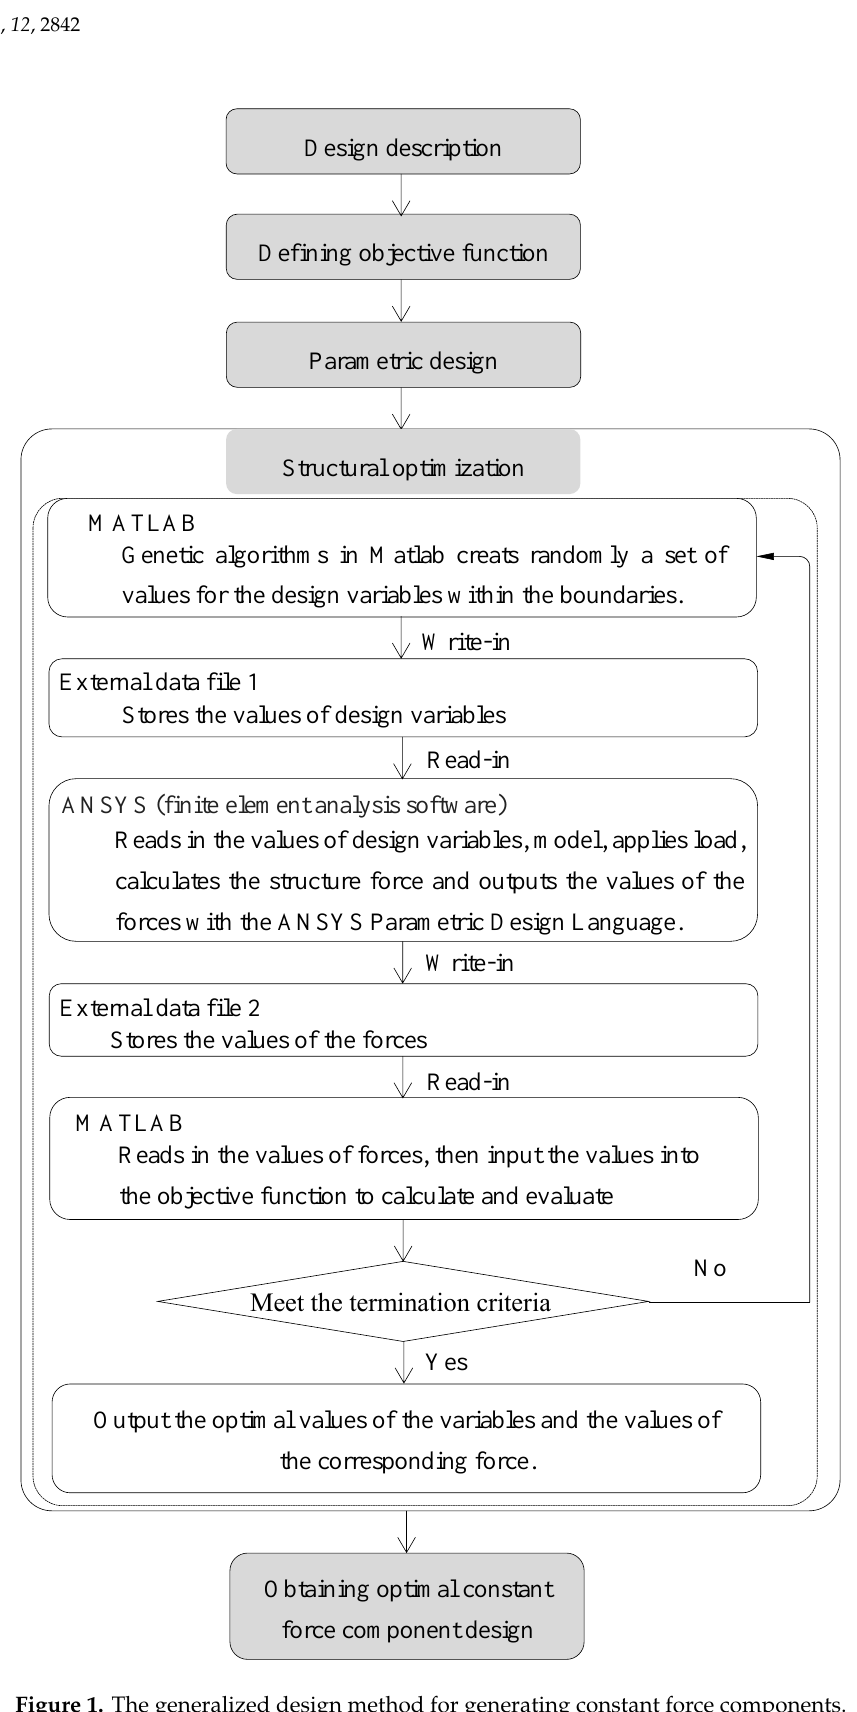
Figure 1. The generalized design method for generating constant force